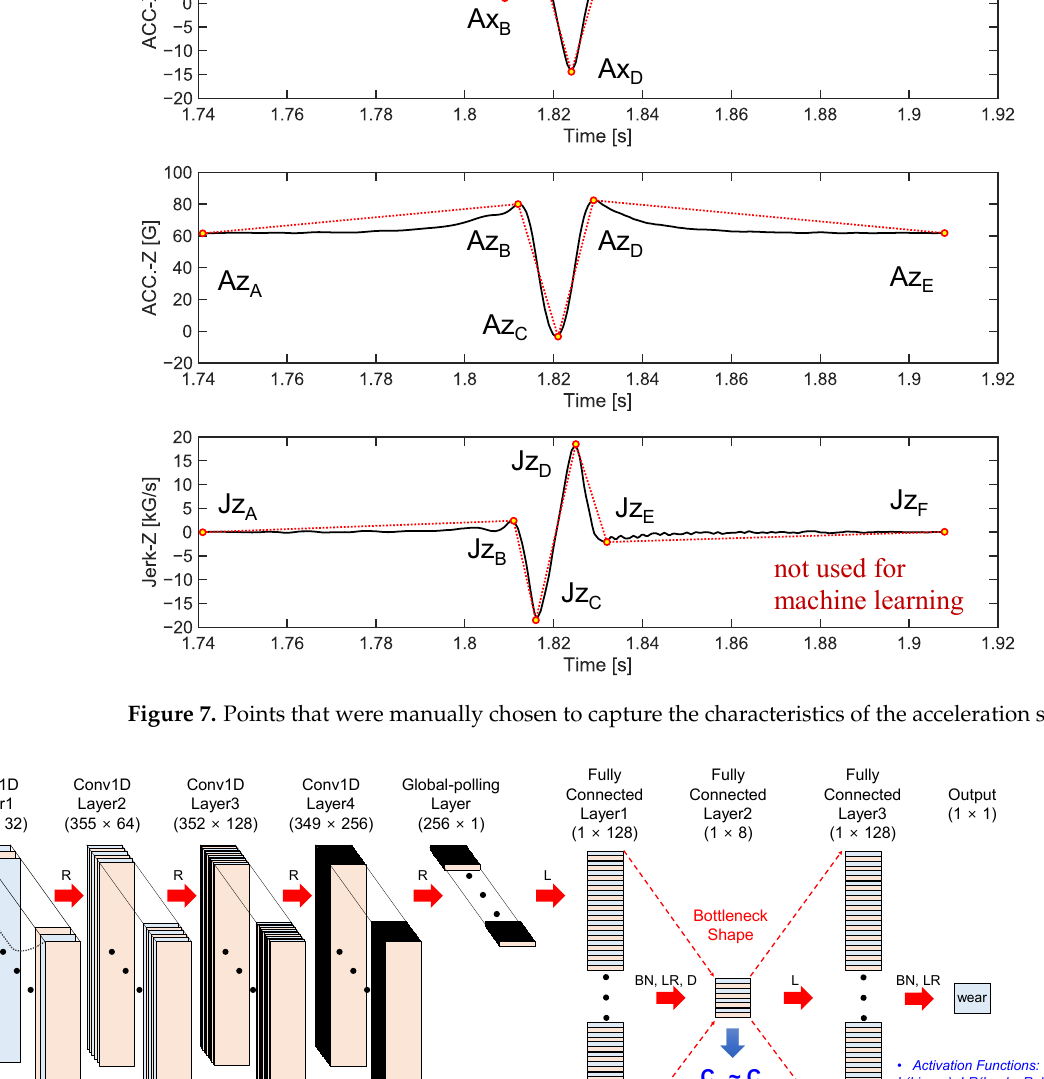
Figure 9. Time histories of circumferential and radial accelerations from tire rolling simulations on the flat road. 3.4.2. Estimation of Tire Wear Using Machine Learning The algorithms used to estimate tire wear amount were developed using the BPNN and the Automated Machine Learning (AutoML) method provided by PyCaret (version 2.3.10) [19]. First, the tire wear amount was predicted based on the features listed in Table 2 using AutoML, which is an ensemble method based on ten widely used ML algorithms, which include Linear Regression [20], Lasso Regression [21], Ridge Regression [22], Elastic Net Regression [23], Lasso Least Angle [24], Orthogonal Matching Pursuit [25], Bayesian Ridge [26], Passive Aggressive Regressor, Huber Regressor [27], and AdaBoost Regressor [28]. Most of the parameters for the ten ML methods provided by the AutoML function were kept as their default values (see Appendix A). Table 3 shows the list of parameters that were altered from their default values in the current study. The AutoML function provided by PyCaret (version 2.3.10) train the ten candidate MLs using the initial hy- perparameter values for each ML method. Then, the three best performing MLs were cho- sen based on their performance among the ten ML models. The chosen three best per- forming MLs were further tuned automatically by altering their hyperparameters. A tire wear prediction algorithm was developed using the ensemble of the three best-